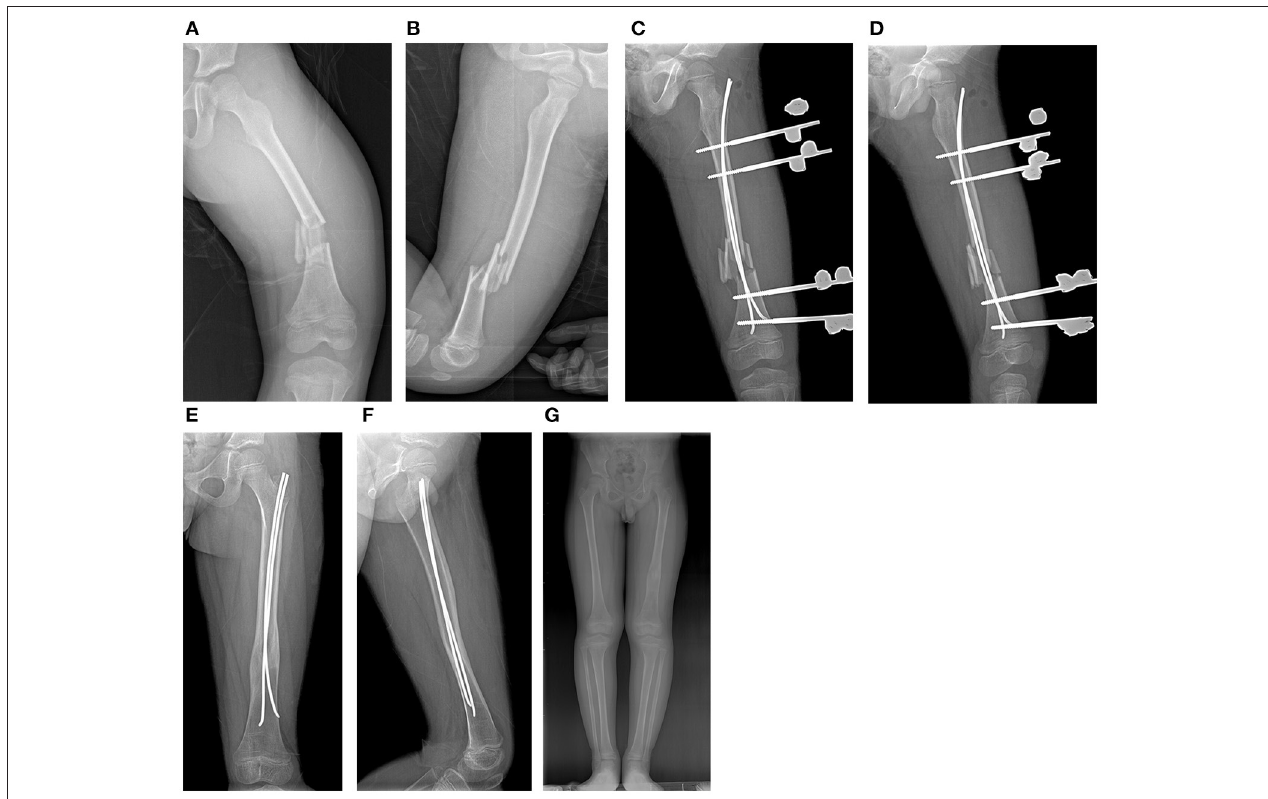
FIGURE 3 | Case 10. (A,B) Comminuted type IV femur fracture in an 8-year-old boy; (C,D) postoperative radiographs; (E,F) removal of EF; (G) final